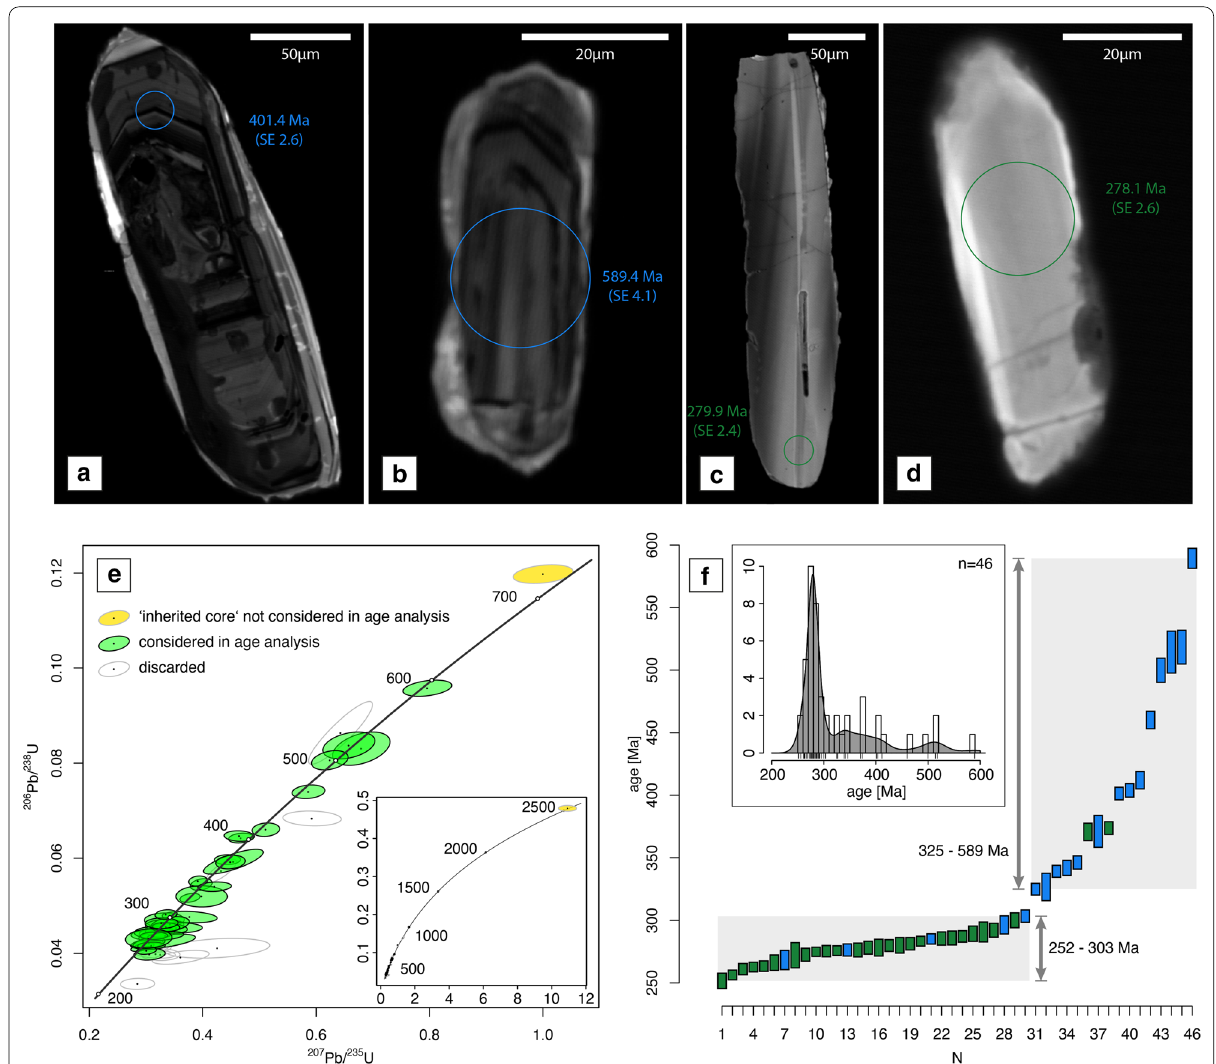
Fig. 16 Images and data of zircons separated from a QB-SZ sample (B20-2801). a – d CL-images, circles show LA-ICP-MS spots and numbers next to it show the corresponding 206 Pb / 238 U -age with one standard error (in brackets). Blue spots indicate LA-ICP-MS measurements of domains with preserved oscillatory zoning ( a ) or slightly blurred oscillatory zoning ( b ), and green spots of domains with strongly blurred zoning ( c ) or almost homogeneous texture ( d ). e Concordia diagram of all LA-ICP-MS measurements (inner figure) and a close-up view up to 750 Ma (main figure). Data highlighted in green correspond to data shown in subfigure ( f ) and are potentially respected for the age determination. Outliers referred to as ‘inherited cores’ are marked in yellow. Basis for discarding additional data (non-filled error ellipses) is indicated in Additional file 4. Error ellipses correspond to two standard errors. f Inner figure shows a histogram of all 206 Pb / 238 U -ages shown in the main figure. Main figure shows 206 Pb / 238 U -ages separated into two age ranges based on a depression in the histogram at around 310 Ma. Colors indicate different textures, which correspond to colors in